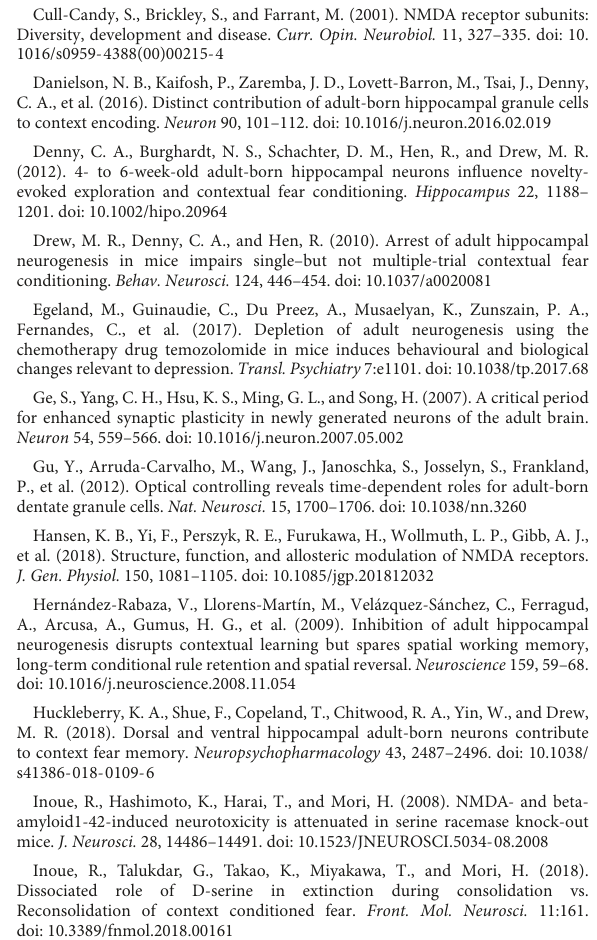
SUPPLEMENTARYFIGURE1 Effects of blockade of D-serine signaling and hippocampal neurogenesis on fear memory during multiple extended retrievals. (A–C) During the course of three extinction procedures on day 1 (A) , 7 (B) , and 14 (C) , there was no significant difference in freezing levels between the two genotypes (WT, n = 11; SRRKO, n = 8). Data are presented as the means ±